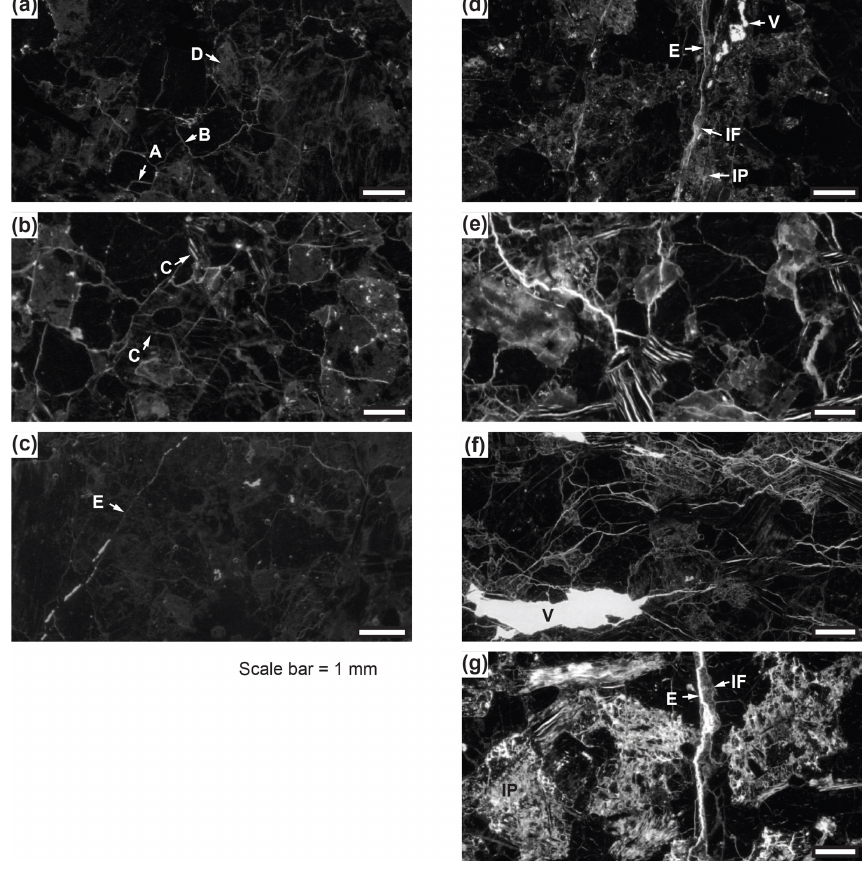
Figure 7. UV-fluorescent light photomicrographs showing microstructural position of connected porosity. Representative situations for fresh granite and pink granite near a single fracture (a) , for fractured and weakly altered granite (b) , for pink granite in a fracture corridor (c) , for green granite (d) , for brown granite near a single fracture (e) , for brown granite in a fracture corridor (f) and for yellow granite in a fracture corridor (g) . D: distributed porosity in plagioclase, B: grain boundary crack, A: intragranular crack, C: cleavage crack, E: intergranular crack, V: cavity, IF: illite infills in fracture and IP: illite aggregate in